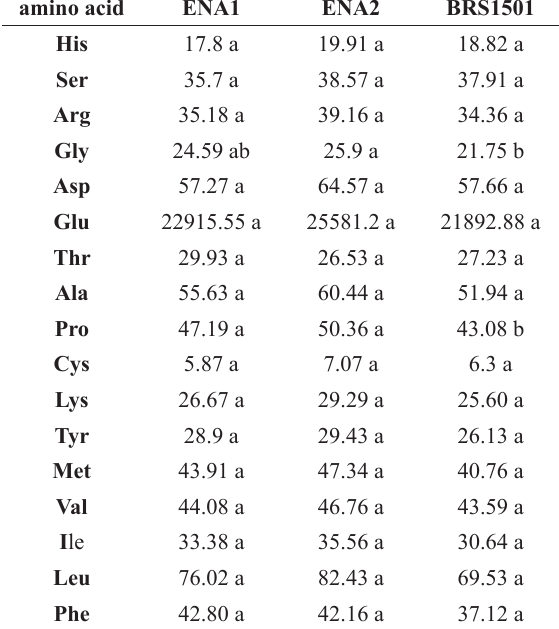
Total amino acid content (mg g -1 protein) in grains of three pearl millets